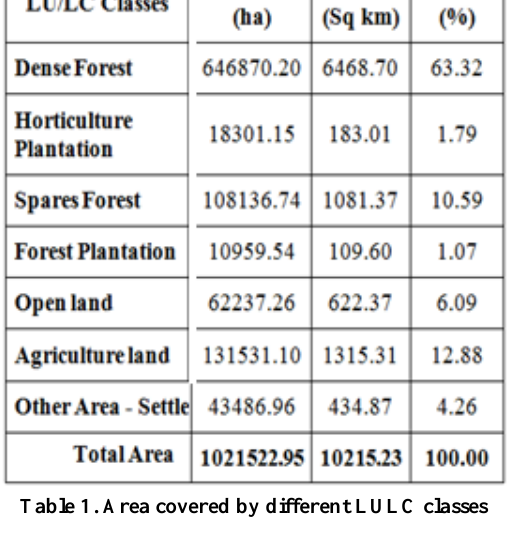
Table 1. Area covered by different LULC classes